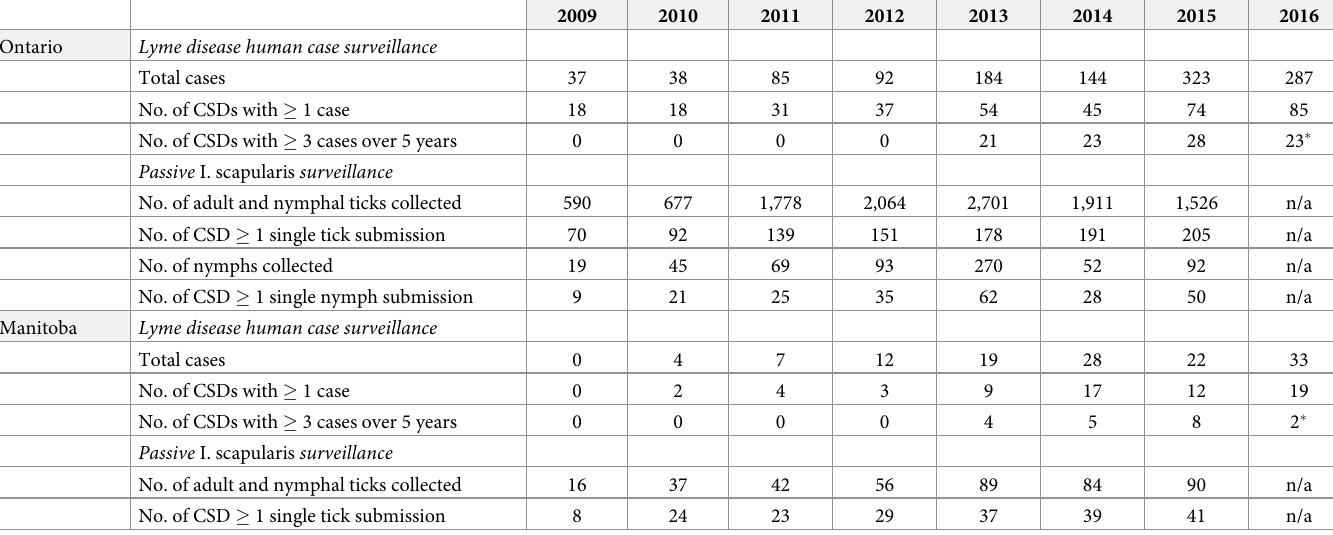
Table 1. Results of Lyme disease surveillance in humans and passive I . scapularis tick surveillance from 2009 through 2016 in Ontario and Manitoba.